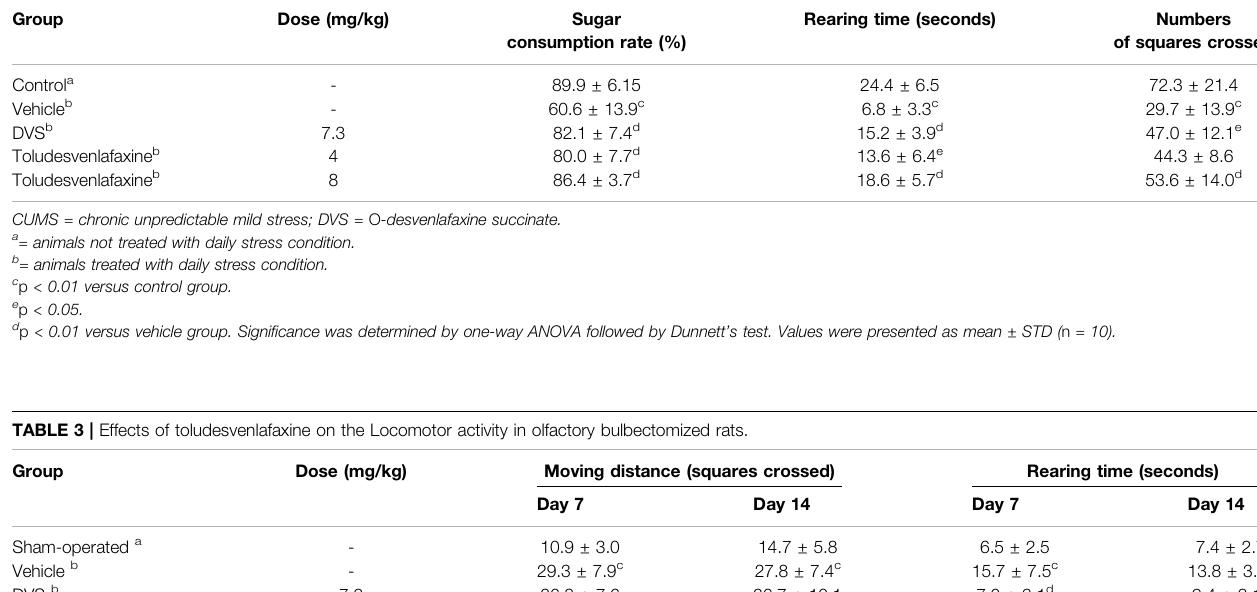
Toludesvenlafaxine b